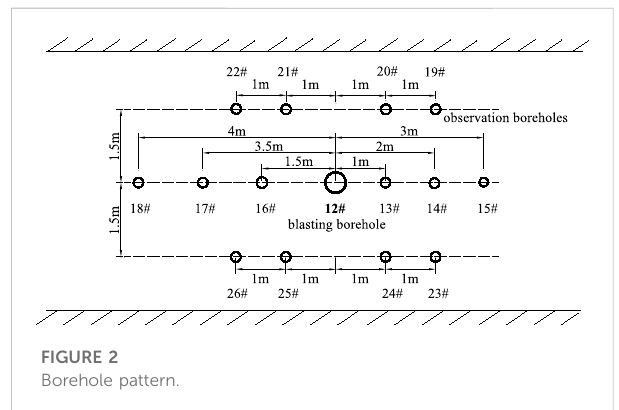
FIGURE 2 Borehole pattern.